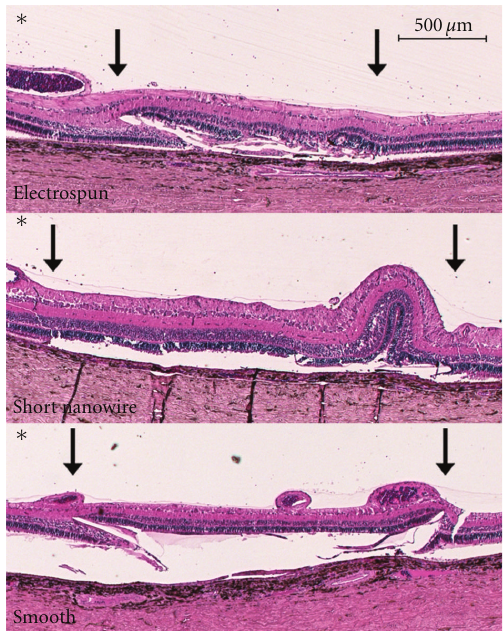
Figure 1: Micrograph of hematoxylin and eosin stained porcine retina after subretinally implanted poly( ε -caprolactone) mem- branes (marked with arrows). Top: Poly( ε -caprolactone) Electro- spun PCL-E) membrane. The left edge of the membrane has penetrated up through the outer retina. Mild choroidal neovascu- larization is seen under the membrane and a few RPE-cells have transformed to a macrophage morphology on the outer face of the membrane. Very little of the retina from the inner nuclear layer, and outward, is preserved and no photoreceptors are preserved. Middle: Poly( ε -caprolactone) Short Nanowire (PCL-SNW) membrane. A retinal fold is seen over the right end of the membrane taking up approximately 30% of the length of the membrane. All retinal layers left of the fold from neurofiber to outer nuclear layer are well- preserved giving approximately 70% well-preserved retina. Half the photoreceptor outer segments are flattened but still present. Bottom: Poly( ε -caprolactone) Smooth (PCL-S) membrane. Both membrane edges are perforated up through the outer retina. The inner membrane-supported retinal layers are well preserved. From the inner nuclear layer, the outer retina is more disrupted with preserved morphology in only approximately half the length of the membrane. The part of fattened but still present photoreceptor outer segments is even less than the rest of the outer retina. No sign of inflammation is seen in either of the micrographs. ( ∗ marks the vitreous